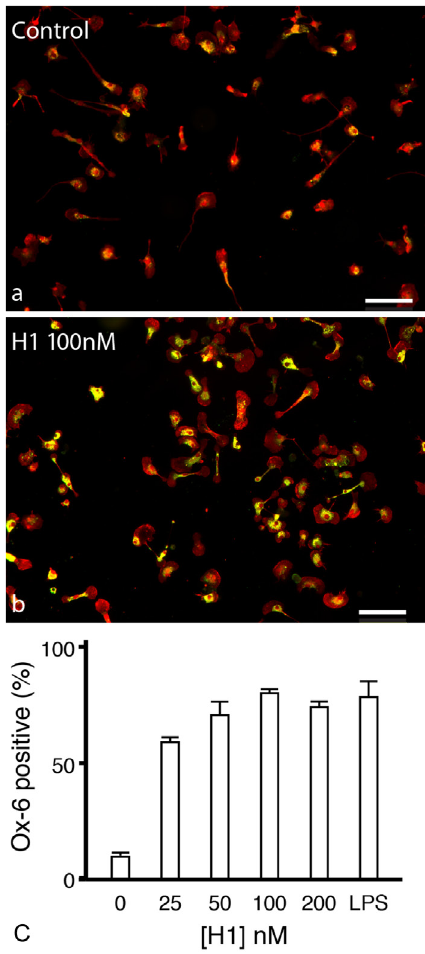
Figure 9. Histone H1 induces microglial chemotaxis. ( a and b ) Chemotaxis towards histone H1 was measured using a Boyden chamber assay and cells that migrated through the filter are labelled in blue. The addition of histone H1 to the lower well of the chamber ( b ) increased microglial migration to the inner membrane surface compared to controls ( a ) demonstrating that histone H1 is a potent chemoattractant for microglia. The increases in microglial migration caused by histone H1 were significant (p<0.007 at 50 nM, p<0.001 at 100 and 200 nM one-way ANOVA, Holm-Sidak posthoc correction). Error bars represent ±